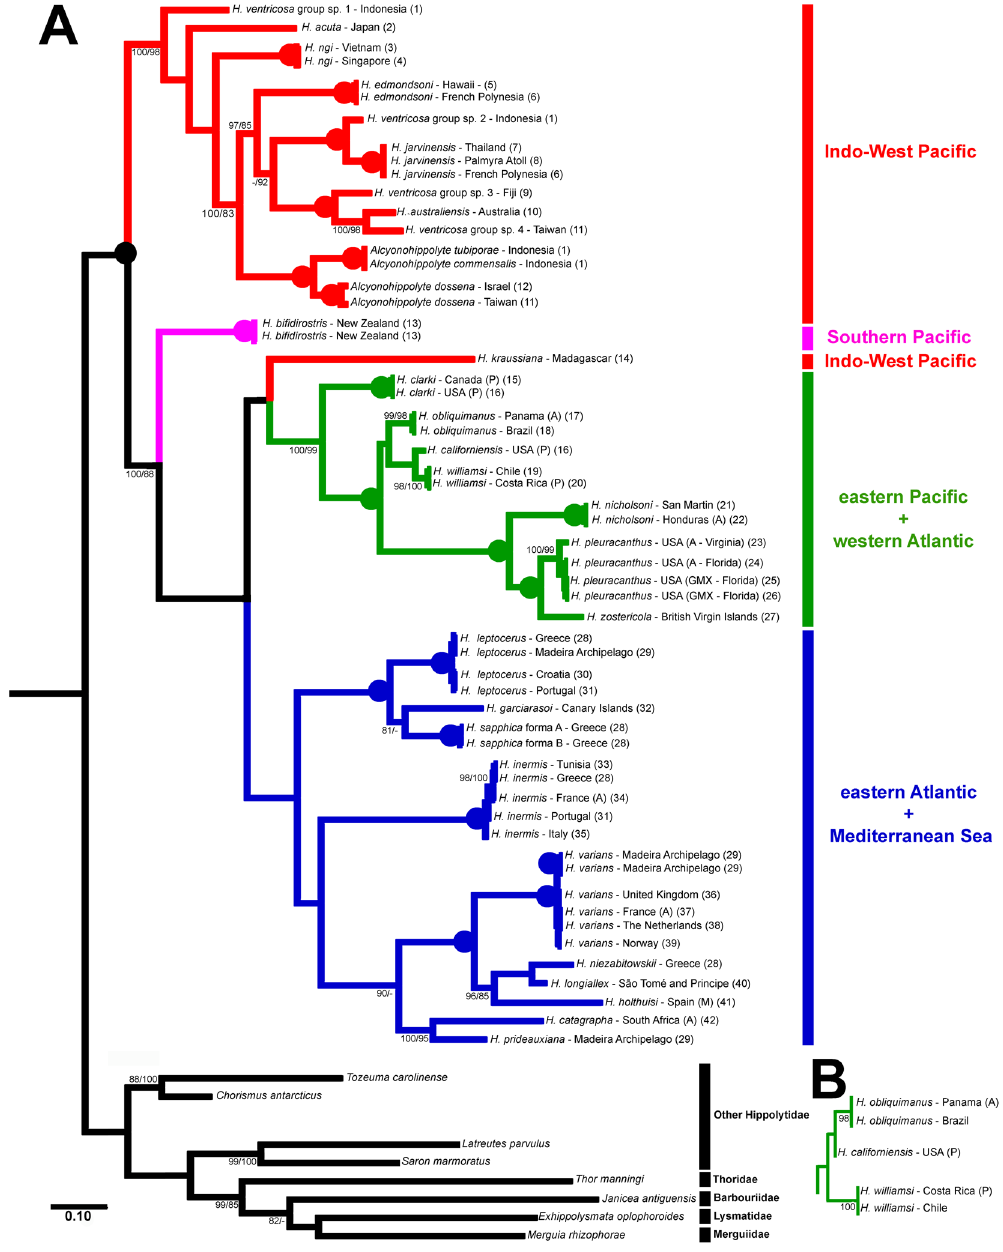
Figure 2. ( A ) Bayesian evolutionary tree based on combined 16S, COI, 18S and H3 DNA sequence data. Numbers at nodes represent posterior probabilities/bootstraps expressed as a percentage (BAY/ML). Numbers < 80% are not shown. Fully supported (100/100) branches are marked with solid circles. The numbers between parentheses correspond to the Figure 1. Data about the specimens can be obtained in the Supplementary Table S1. ( B ) Maximum Likelihood tree showing the only topological difference found between both analyses in the position of H . californiensis , H . obliquimanus and H . williamsi . Abbreviations for seas and oceans are A: Atlantic Ocean, C: Caribbean Sea, GMX: Gulf of Mexico, M: Mediterranean Sea, P: Pacific